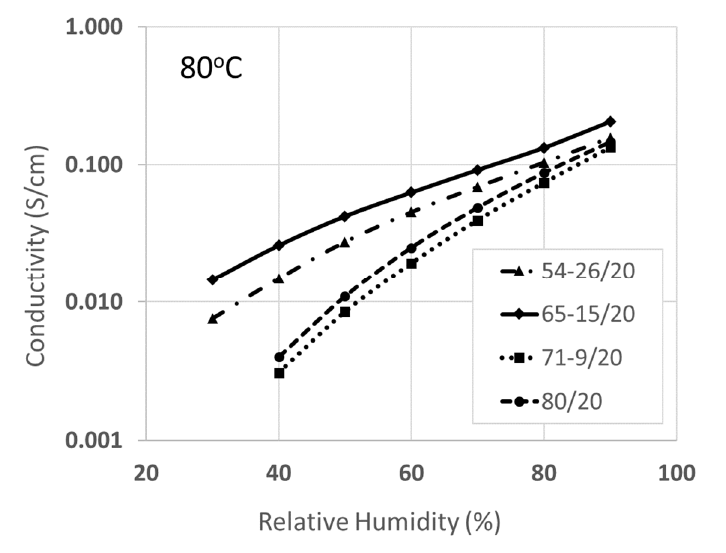
Figure 3. In-plane proton conductivity at 80 °C versus relative humidity for Type-A hybrid membranes, where a SiOxSO 3 H network was incorporated into the PFSA matrix. The PFSA-SiOxSO 3 H/PVDF weight percent composition of the membranes is given in the insert (the 80/20 film has no SiOxSO 3 H).